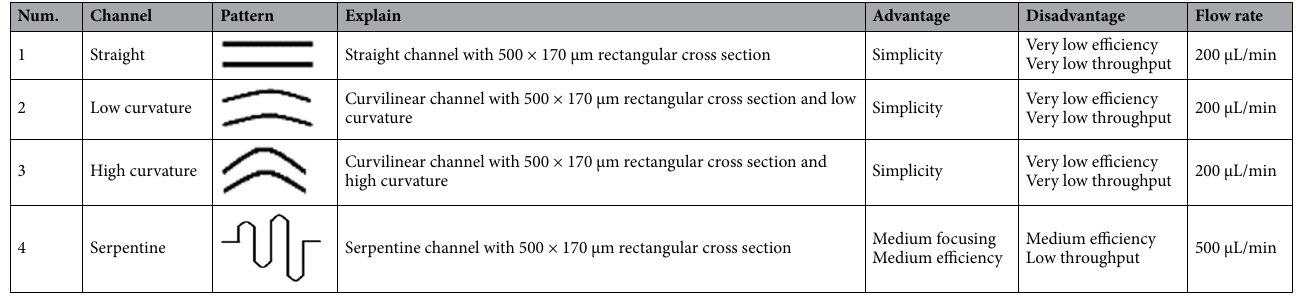
Table 2. Summary of simulation results along with schematic of their geometric pattern.